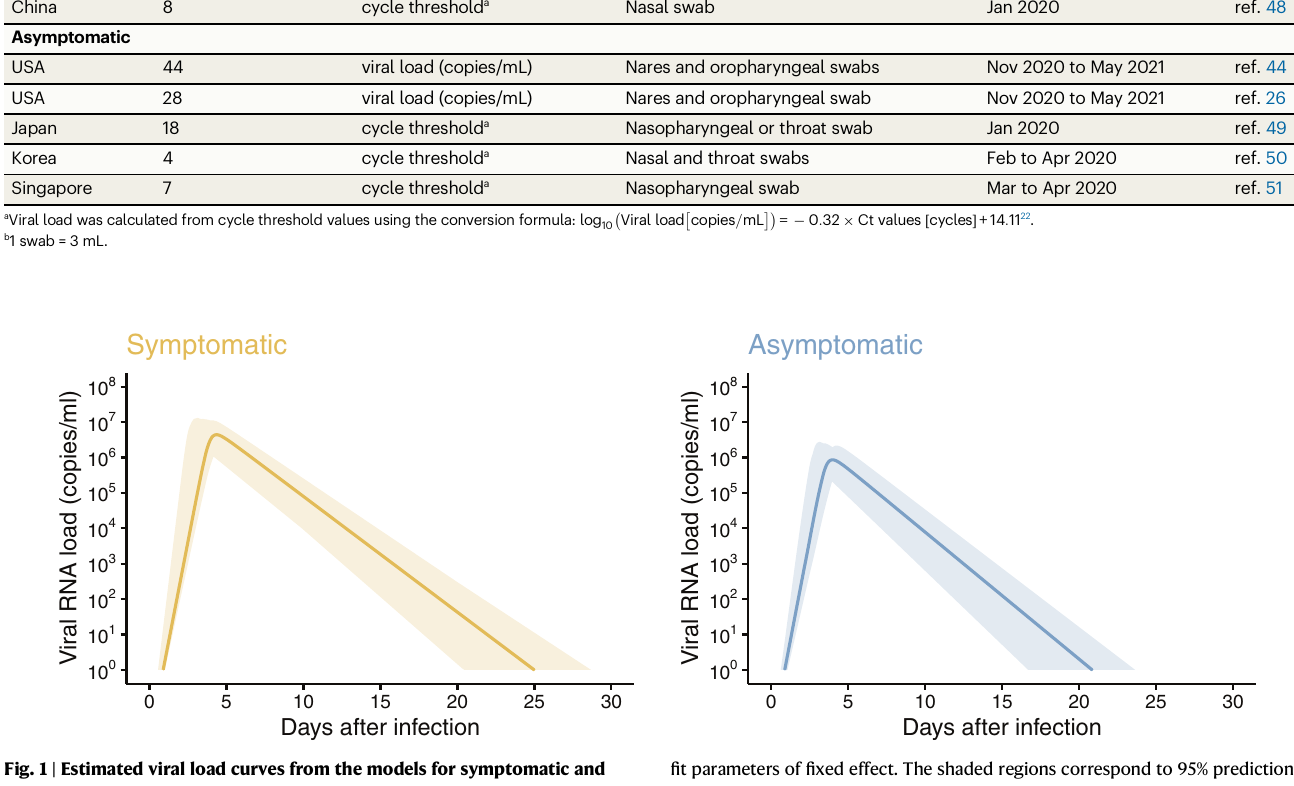
Fig. 1 | Estimated viral load curves from the models for symptomatic and asymptomaticcases. Thesolidlinesaretheestimatedviralloadcurvesforthebest